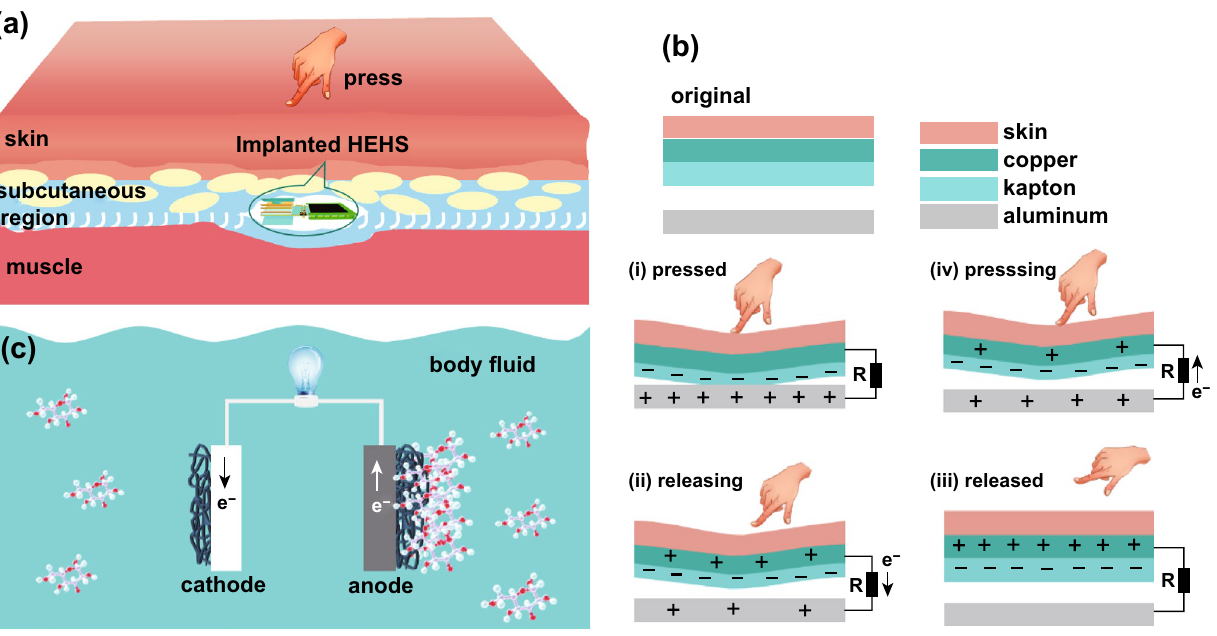
Fig. 1 a Conception graph of an implanted HEHS harvesting biomechanical energy and biochemical energy in body. b Biomechanical energy‑ harvesting mechanism by TENG under the finger press. c Biochemical energy‑harvesting mechanism by GFC from glucose molecules in body